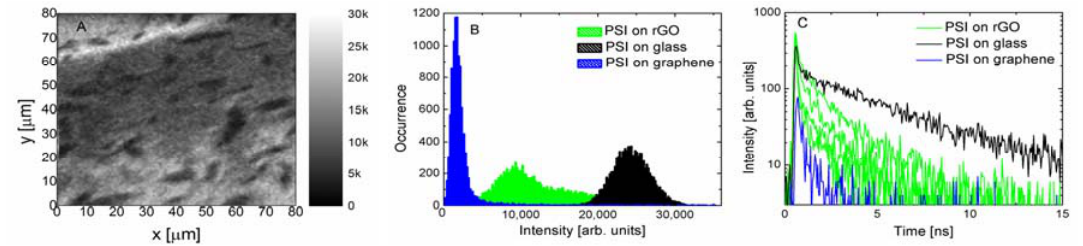
Figure 4. ( A ) Fluorescence intensity map measured for the PSI complexes deposited on thermally reduced graphene using the excitation wavelength of 485 nm. ( B ) Histogram of fluorescence intensity extracted from the map (green) compared to the data obtained for PSI complexes deposited on a glass substrate (black) and a monolayer graphene (blue). ( C ) Fluorescence intensity decays measured for PSI complexes on thermally reduced graphene oxide (green lines) for several spots on the map shown in (A) compared both with the reference (black line) and the decay measured for PSI on monolayer graphene (blue line).